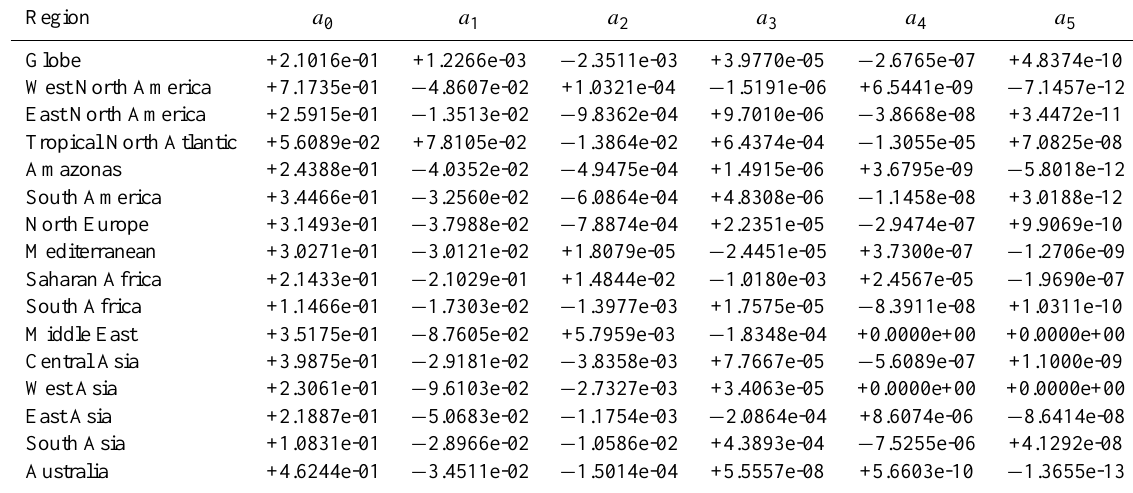
Table A1. Best fit (least-square error) coefficients of Eq. (1) for the relative mean error in each geographical region. Region Globe